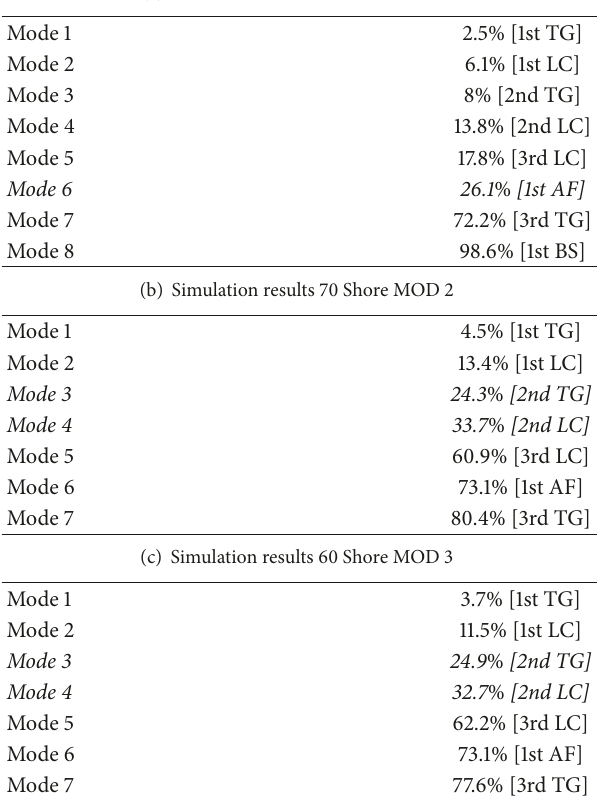
Table 7: Numerical natural frequencies (in % of 𝑓 max ) estimated by the FE model regarding the modified drivelines. Italic characters highlight frequencies that fall in the frequency band of interest.